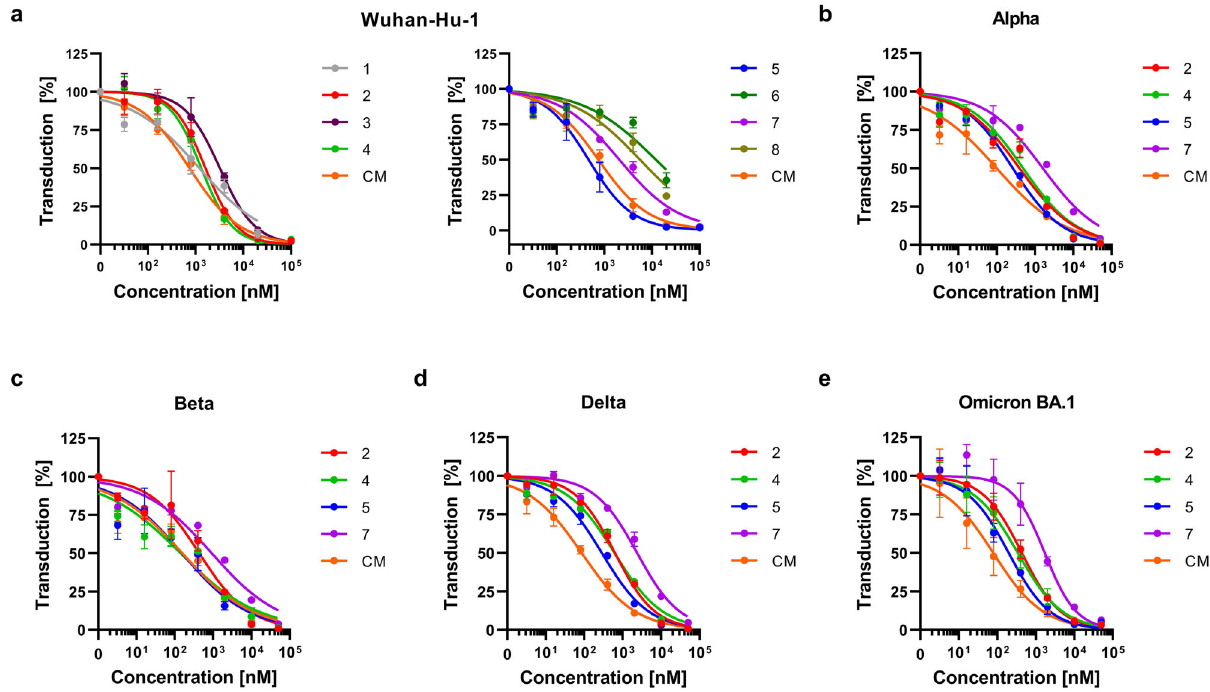
Fig. 5 Peptidomimetic inhibitors reduce SARS-CoV-2 spike-driven entry. Peptidomimetic inhibitors and the small molecule camostat mesylate (CM) were added to Caco-2 cells. After 1 h, cells were transduced with lentiviral SARS-CoV-2 pseudoparticles carrying the spike protein of SARS-CoV-2 wild- type ( a ), Alpha ( b ), Beta ( c ), Delta ( d ), or Omicron BA.1 ( e ) variant of concern. Transduction rates were assessed 2 days post transduction by measuring luciferase activity in cell lysates. Shown are the means ± SEM of n = 2 independent experiments, each performed in triplicates. Calculated IC 50 values for each compound are presented in Supplementary Table